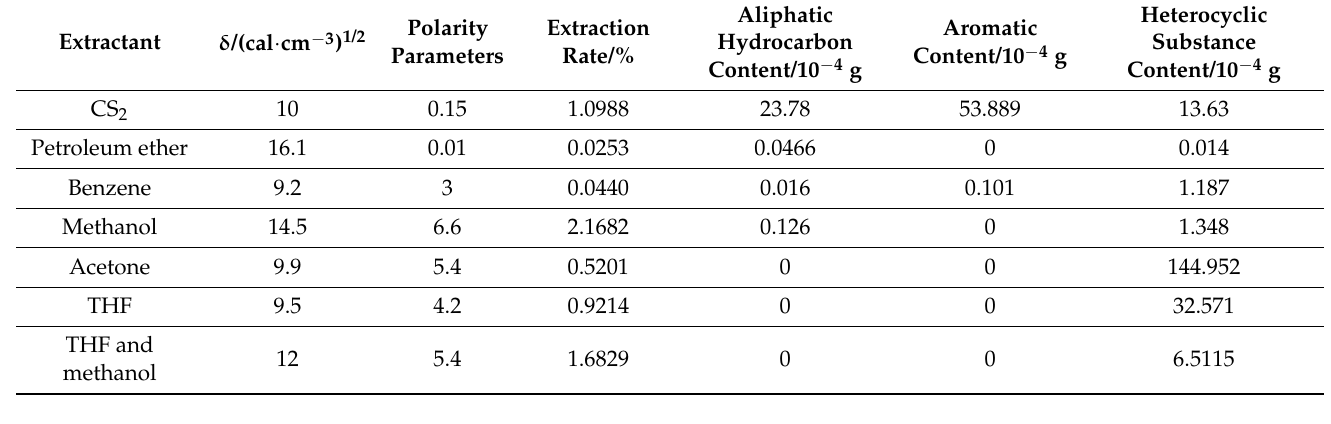
Table 2. Extraction rates and composition of extractables in graded extraction of Huolinguole coal.